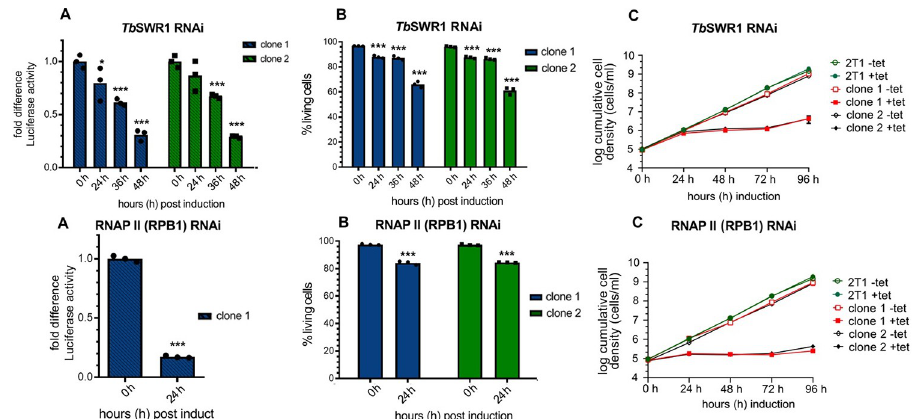
Fig 5. Depletion of TbSWR1 caused a decrease of reporter luciferase activity within a PTU. A luciferase reporter construct was integrated into the tubulin array in both RNAi cell lines. The Tb SWR1 RNAi clone 6 was used for transfection (Figs 3 and S1C Fig). Samples for the luciferase assay were normalised to cell numbers. (A) Luciferase activity was monitored for 48 h after induction of RNAi in two independent clones. Values of non-induced cells were set to 1. (B+E) Live/dead staining of each RNAi cell line was performed in triplicates at the same time points. (C+F) Growth of parasites was monitored for 96 hours after RNAi-mediated depletion of TbSWR1 and RBP2 using tetracycline (tet) induction. The parental 2T1 cell line was used as a control (n = 3). (D) As a positive control, luciferase activity of the same reporter construct was measured in an RNAP II RNAi cell line. (N = 3 for all depicted experiments; ��� = p-value < 0.001; �� = p-value 0.001–0.01; � = p-value 0.01–0.05).